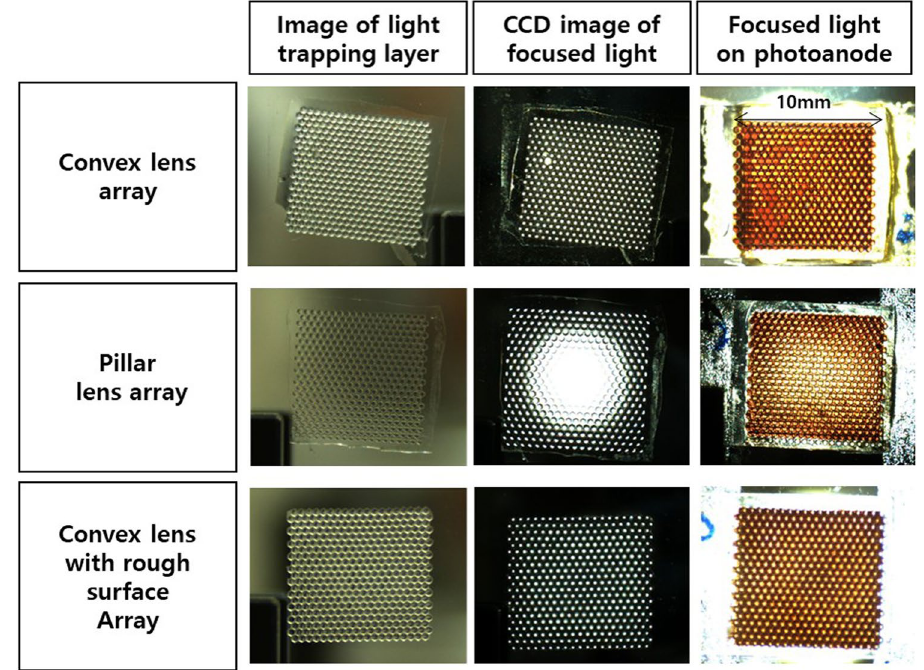
Figure 3. Charge coupled device (CCD) images of light-trapping layers composed of a ( a ) lens array, ( b ) pillar- shaped lens array, and (c ) lens array with rough surfaces. The images on the left are the light-trapping lenses, those in the middle are the light distribution and focus of each light-trapping layer, and those on the right are photoanodes with light-trapping layers when illuminated by a light-emitting diode